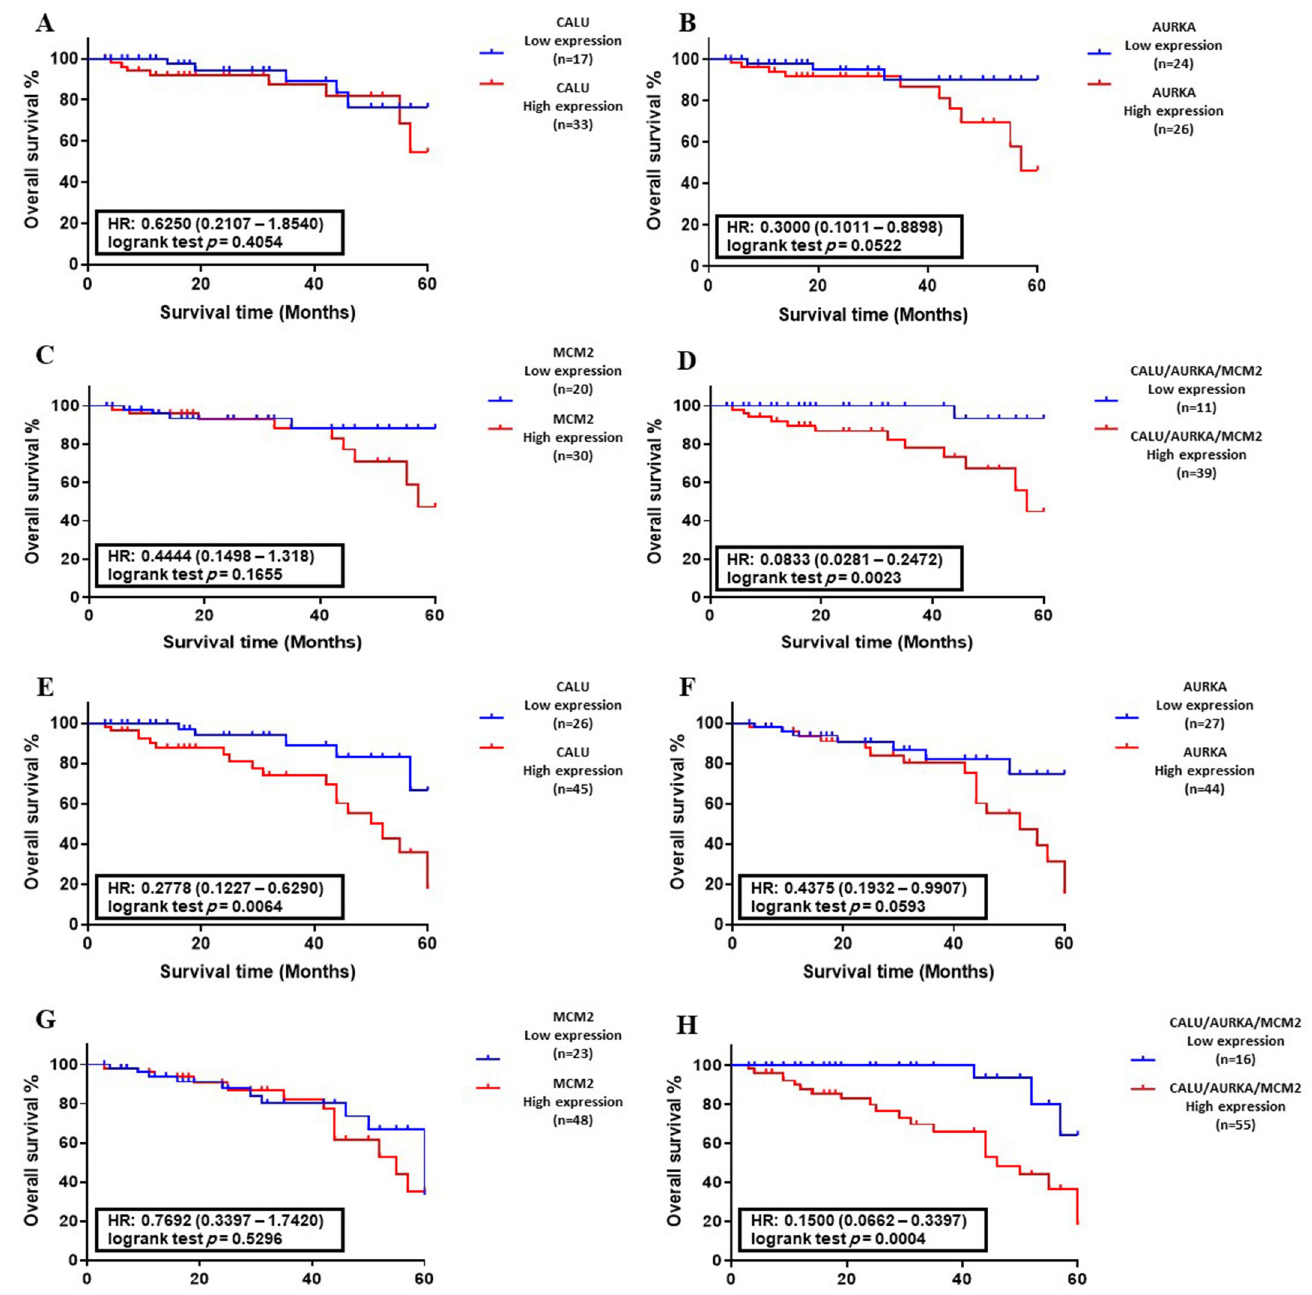
Fig 7. Association between DEGs expression and overall survival (OS) of lung cancer patients. (A-D) Kaplan–Meyer analysis of CALU, AURKA, MCM2, and CALU/AURKA/MCM2 panel in the training set (n = 108). (E-H) Kaplan–Meyer analysis of CALU, AURKA, MCM2, and CALU/AURKA/MCM2 panel in the validation set (n = 158). Data indicated that the abnormal level of CALU associated with the OS of patients with lung cancer (P < 0.01). Also, CALU, AURKA, and MCM2 in the form of a panel had a significant correlation with OS of lung cancer patients in training set ( P < 0.01) and validation set ( P < 0.001).